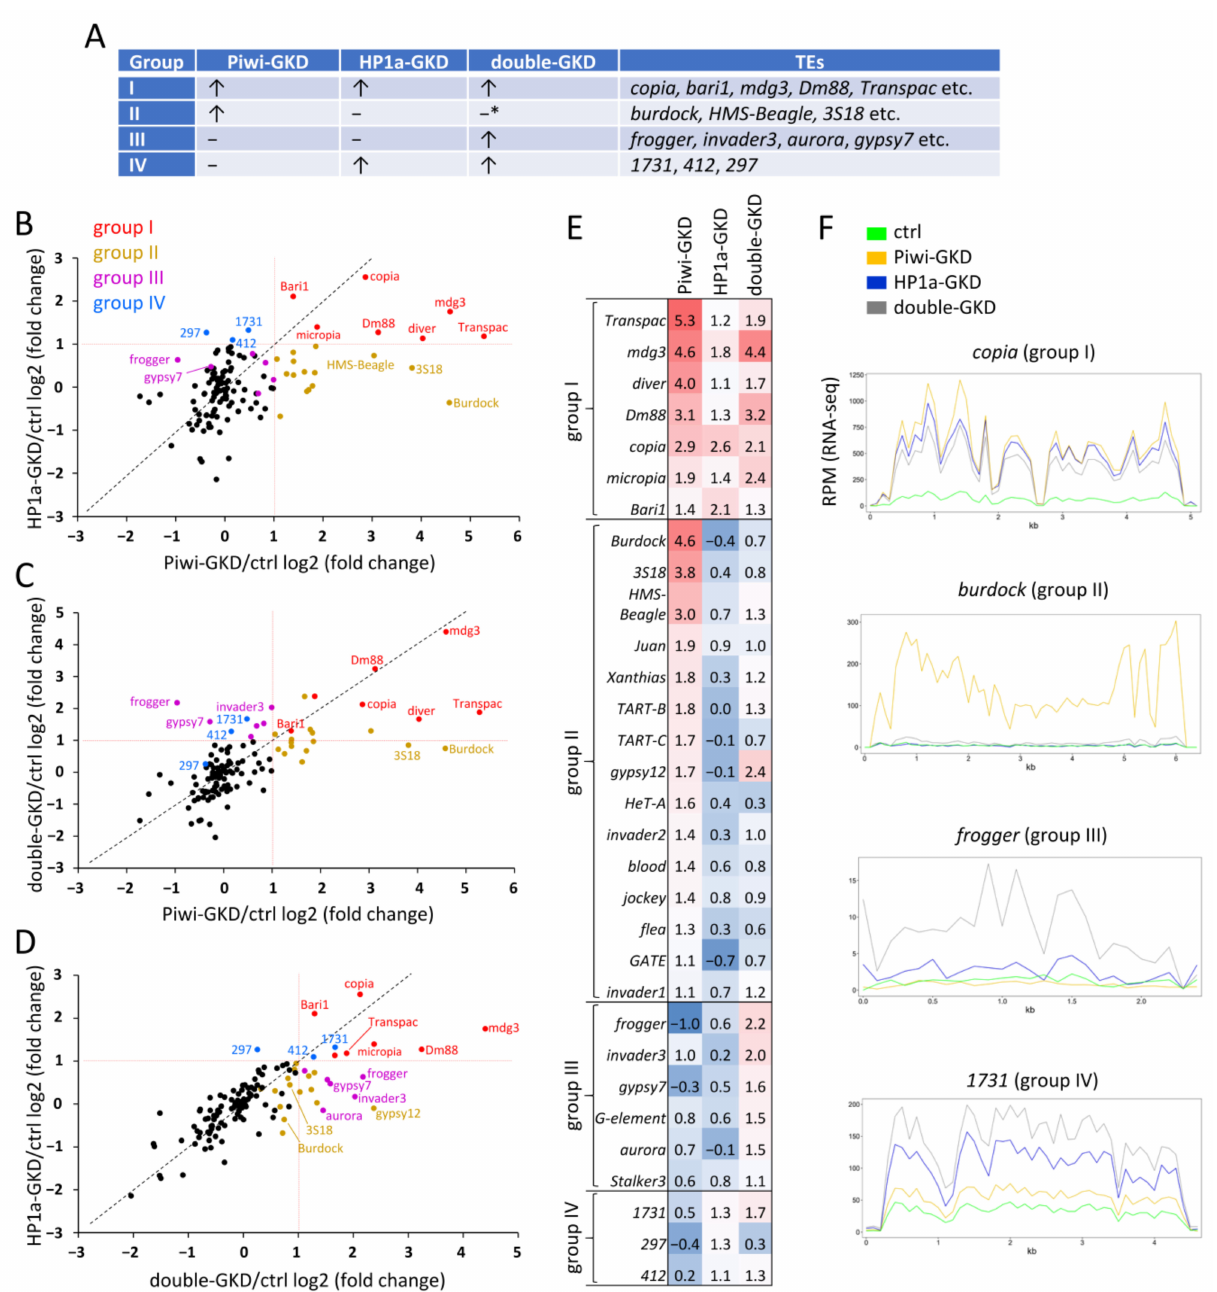
Figure 2. Germline knockdowns of Piwi and HP1a lead to the derepression of only partially overlapping TE sets. ( A ) Examples of TEs belonging to different groups according to their responses to Piwi-, HP1a- and double-GKD. Upregula- tion is indicated by arrows. * Several TEs of group II are upregulated upon double-GKD. ( B ) Scatterplot displaying fold upregulation (log2) upon Piwi-GKD relative to the Ctrl for TEs ( n = 123) versus fold upregulation (log2) upon HP1a-GKD. The TEs of group I are marked in red, group II in dark yellow, group III in purple and group IV in blue. ( C ) The same for Piwi-GKD versus double-GKD. ( D ) The same for double-GKD versus HP1a-GKD. ( E ) Heatmap showing log2-fold upregulation upon Piwi-GKD, HP1a-GKD and double-GKD relative to the Ctrl for TEs belonging to different groups. Upregulation over 2-fold is shown in white and red and less than 2-fold (log2 = 1) is shown in blue. ( F ) Density profiles of the RNA-seq signal in 100-bp windows on copia (group I), burdock (group II), frogger (group III) and 1731 (group IV) TEs showing an approximately even distribution of reads along the full-sized TE body not emanating from any single TE fragment. Green, yellow, blue and grey lines indicate reads per million (RPM) levels in the control, Piwi-GKD, HP1a-GKD and double-GKD,